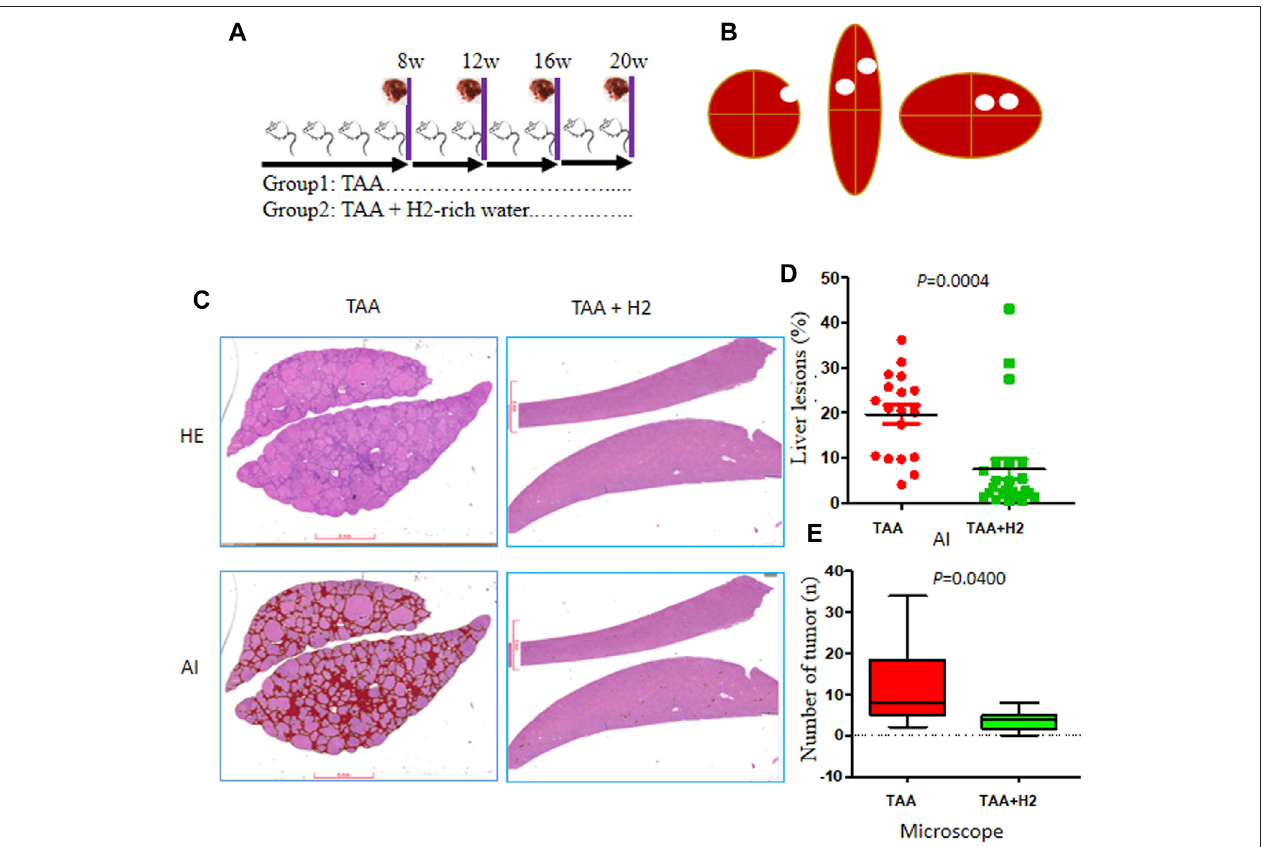
FIGURE 2 | The morbidity of intrahepatic lesions in each group at 20 weeks. (A) Three (TAA and TAA + H 2 ) of rats were sacri fi ced and examined at 8, 12, 16, and 20 weeks. (B) Whitenodulesonthesurfaceandwithintheliverwerecounted. (C) Automatedhistologicalclassi fi cationwasdevelopedtoevaluatedliverlesionsbasedon convolutional neural networks (CNNs). Representative whole slide images of liver sections from the two groups were presented (H&E: upper; AI: lower). AI, arti fi cial intelligence. (D) The ratio of liver lesions assessed by the AI algorithm in the two groups. (E) The number of microscopic cholangio fi brosis counted under optical microscope in two